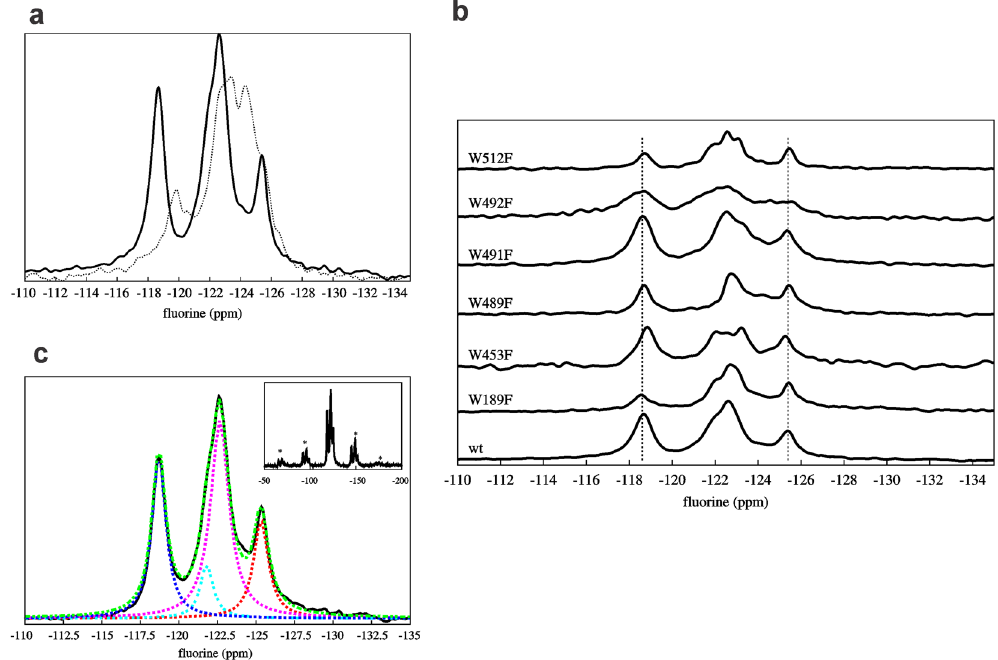
Figure 6. Comparison of solid-state NMR spectra of 19 F-LLO protein when bound to POPC/Chol vesicles and free in MES buffer with Trp peaks assignment. ( a ) Solid-state 19 F spectra of free LLO in MES buffer (dotted line) and when bound to multilamellar vesicles composed of POPC/Chol (solid line), ( b ) Assignments of peaks with single point Trp mutants. The fits to peaks are reported in Table 2, and ( c ) Fitting of Lorentzian functions to 19 F NMR MAS spectrum of the 19 F-LLO bound to POPC/Chol membranes (see Table 2). Experimental data - black, overall fit - green, individual components - red, magenta, cyan, blue. Inset shows spinning side bands in the MAS solid-state 19 F-LLO NMR spectra. Chemical Linewidth at half Relative Tryptophan shift (ppm) height (ppm) Intensity (a.u.)